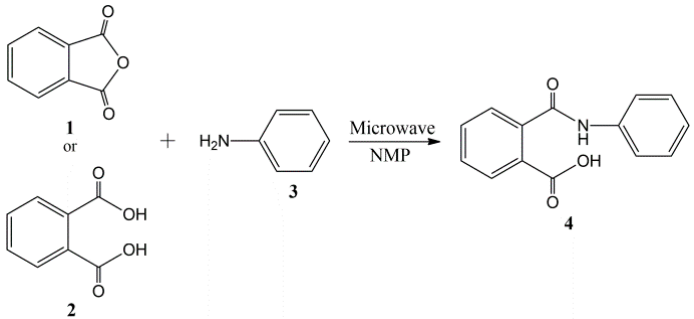
Scheme 2. Model study of the reaction of 1 (phthalic anhydride) (or 2 (phthalic acid)) with 3 (aniline). 4 : N -phenylphthalamic acid.